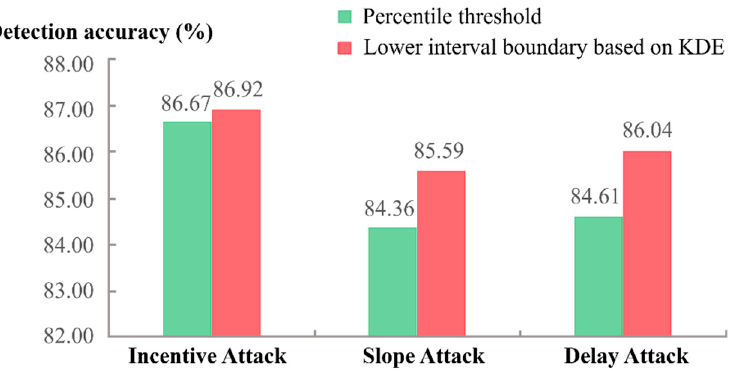
Figure 21. Detection accuracy of different judgement threshold determination